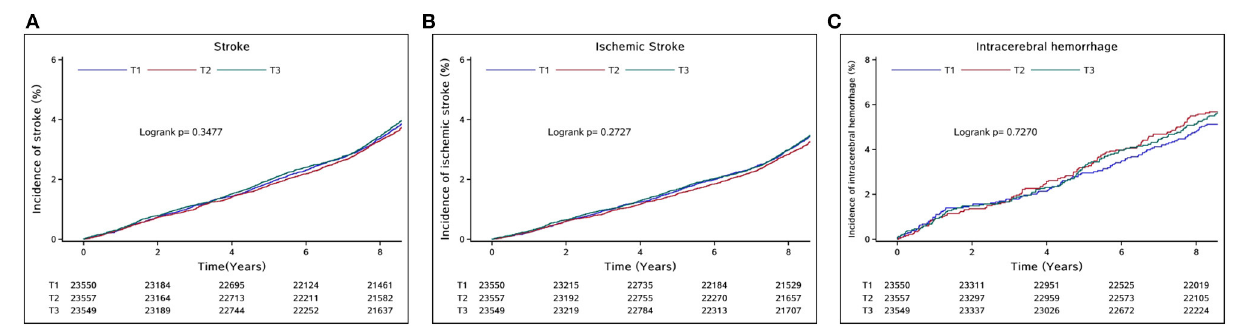
and 1.08-fold increased risk of total stroke and IS were